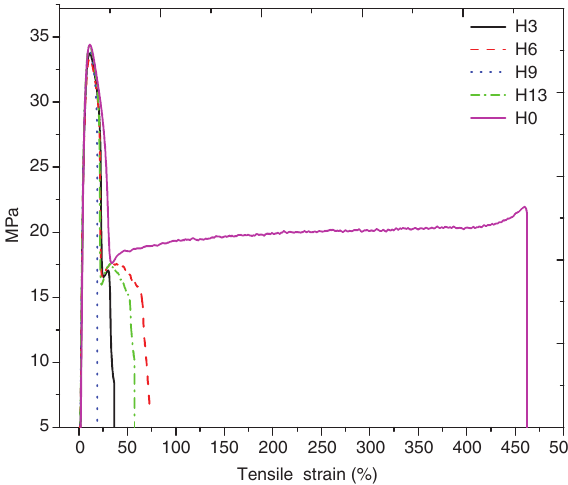
Figure 5: Stress–strain curve for the PP and PP/LDH nanocomposites.